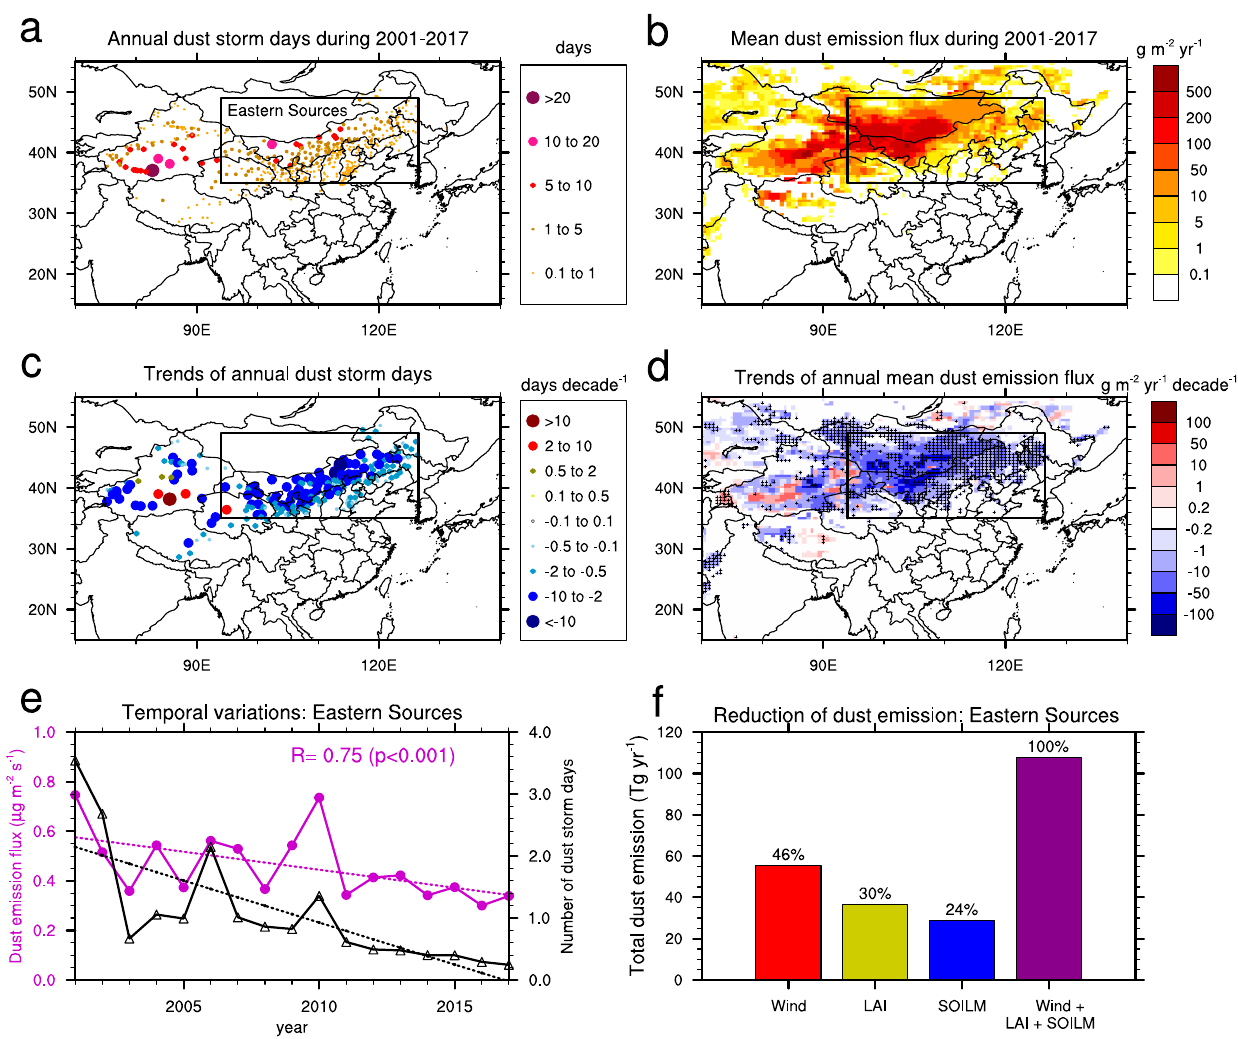
Fig. 1 | Spatio-temporal variations of observed dust storm days and simulated dust emission fl ux. a Annual dust storm days ( N DS ; days) averaged over 2001 – 2017 and c the linear trends of N DS (days decade − 1 ; only stations with p <0.1 are shown). The dust storm days are recorded at 2340 synoptic weather observations. The stations with N DS <0.1 days are not shown in ( a ). b Annual mean dust emission fl ux ( F emis ; g m − 2 yr − 1 ) during 2001 – 2017 and d the linear trends of F emis (g m − 2 yr − 1 decade − 1 ; p <0.1 for regions marked with crosses) simulated by the dust emission model (DuEM v1; from the baseline experiment in Table 1) during 2001 – 2017. The black rectangle denotes the Eastern Sources (35-49 °N, 94-126.5 °E), from which the dust particles are mainly transported eastward and southward to affect the denselypopulated regionsofChina. e